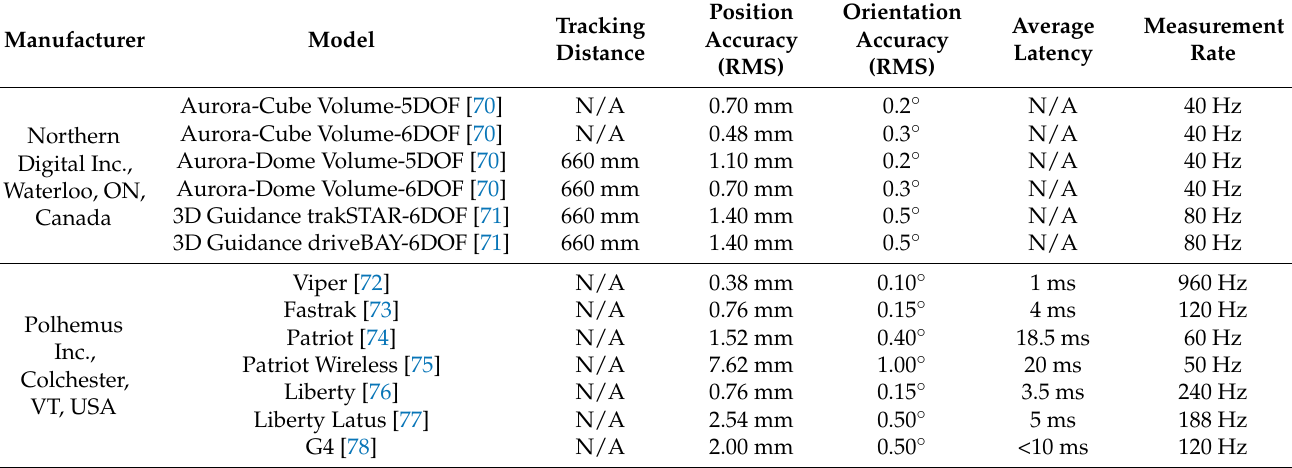
Table 2. Summary of commercially available electromagnetic tracking